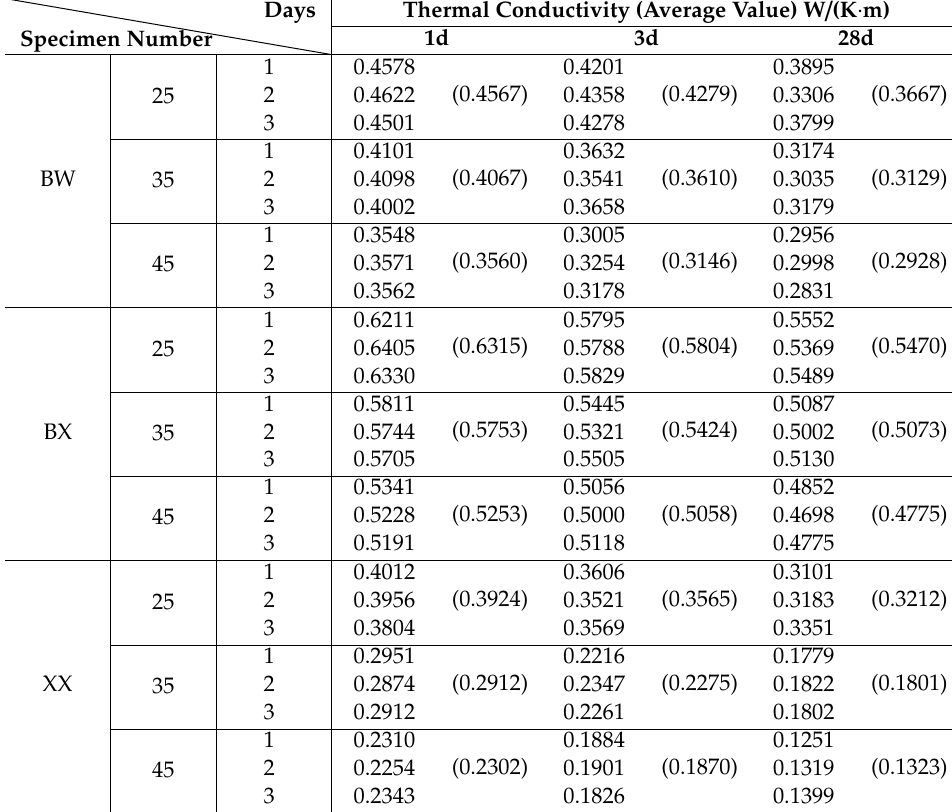
Table 10. Thermal conductivity measurement data